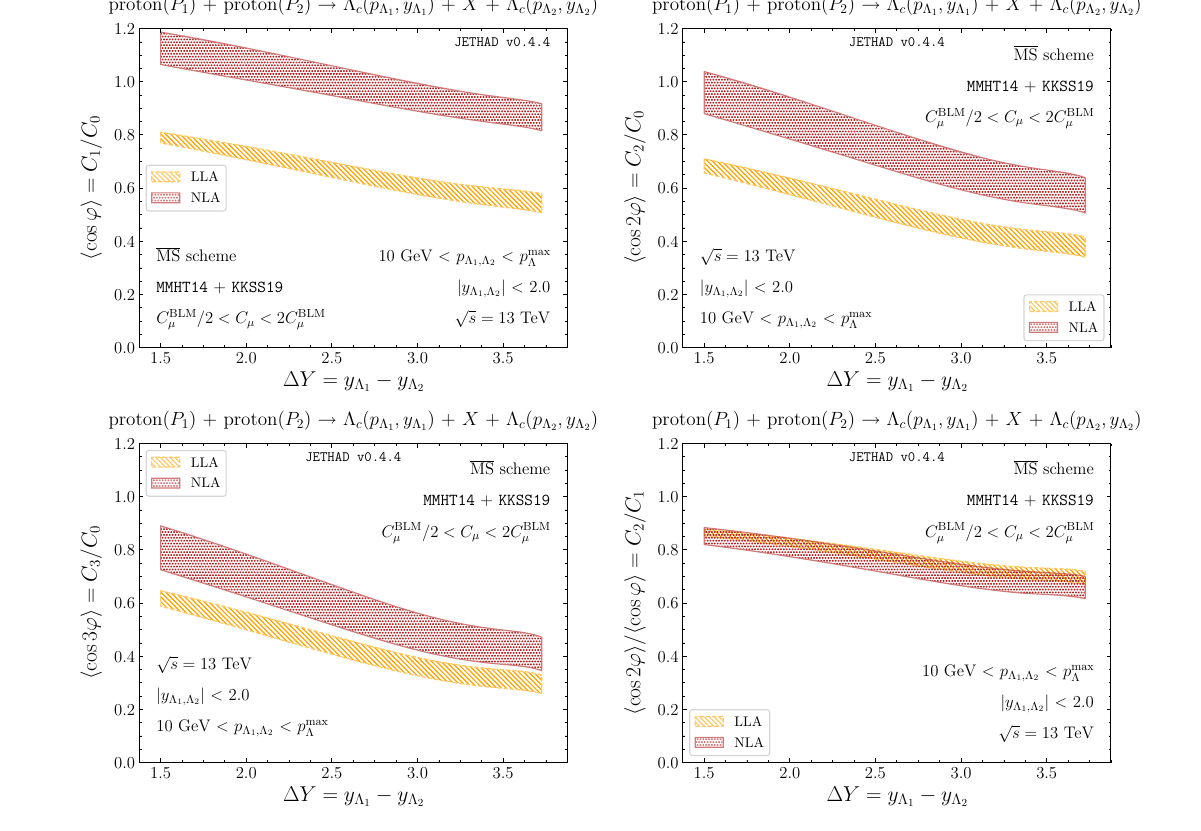
Fig. 5 Behavior of azimuthal-correlation moments, R nm ≡ C n / C m , as functions of (cid:5) Y , in the double (cid:2) c channel, at BLM scales, and for √ s = 13 TeV. Error bands provide with the combined uncertainty com-